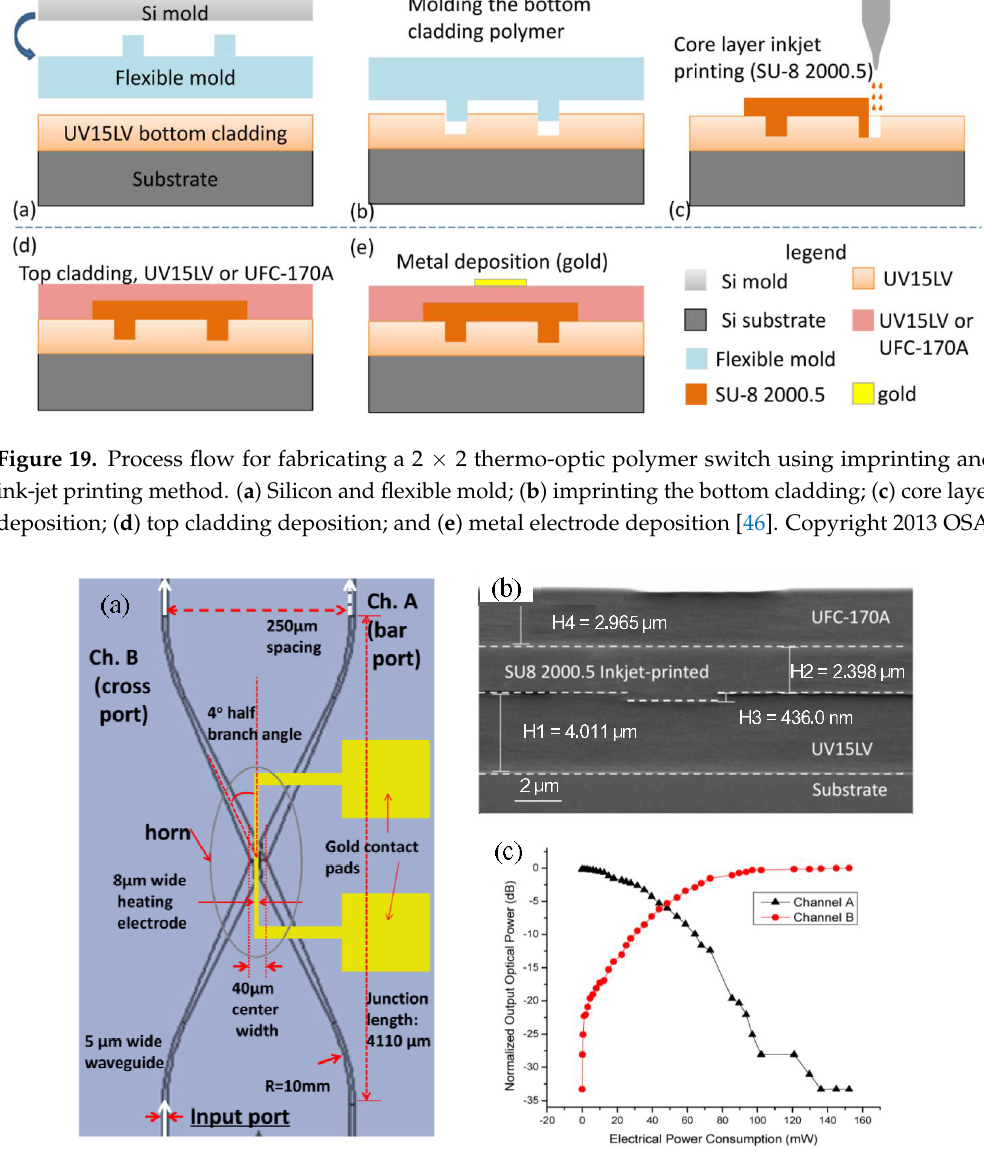
Figure 21. UV imprinting steps for integrated waveguide VOA-based on polymer materials. ( a ) Spin-coating and curing for under-cladding; ( b ) core material dispensing; ( c ) imprinting under pressure with UV irradiation; ( d ) detachment of the mold; ( e ) spin-coating and curing for cover-cladding; and ( f ) TO electrode patterning [74]. Copyright 2006 Elsevier.